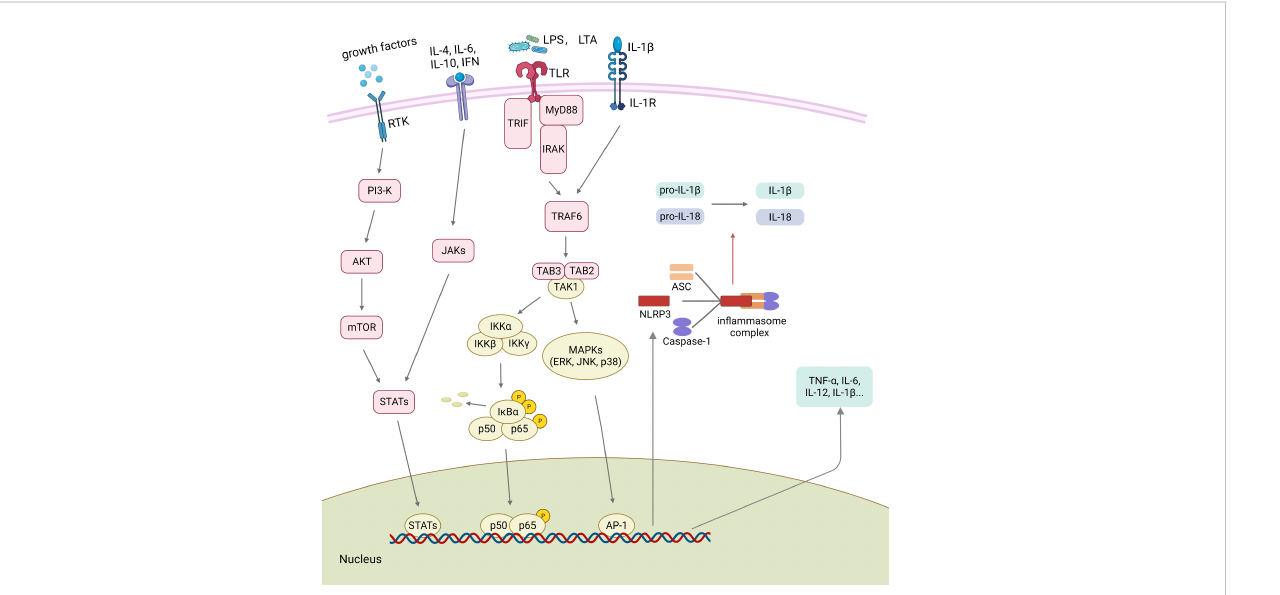
FIGURE 2 Polarization-related signaling transduction in macrophages. The binding of growth factors or cytokines to their receptors activates STATs through JAKs or PI3K/AKT pathway signaling. Activated TLRs and IL-1 b R trigger downstream signaling, including the NF- k B and the MAPK signaling pathways. Several transcription factors, such as AP-1, STATs, and p65, are regulated by the upstream signaling pathways and further promote the assembly of NLRP3 in fl ammasome. Then, the activated NLRP3 in fl ammasome promotes the maturation of pro-IL-1 b and pro-IL-18. ASC, apoptosis-associated speck-like protein containing a CARD; IFN, interferon; IL, interleukin; LPS, lipopolysaccharide; IRAK, Interleukin-1 receptor-associated kinase; LTA, lipoteichoic acid; MyD88, myeloid differentiation primary response protein 88; NLRP3 NOD-like receptor family pyrin domain containing 3; PAMPs, pathogen-associated molecular patterns; RTK, Receptor Tyrosine Kinases; STATs, signal transducers and activators of transcription; TLR, toll-like receptor; TNF- a , tumor necrosis factor-alpha; TRIF, TIR-domain-containing adapter-inducing